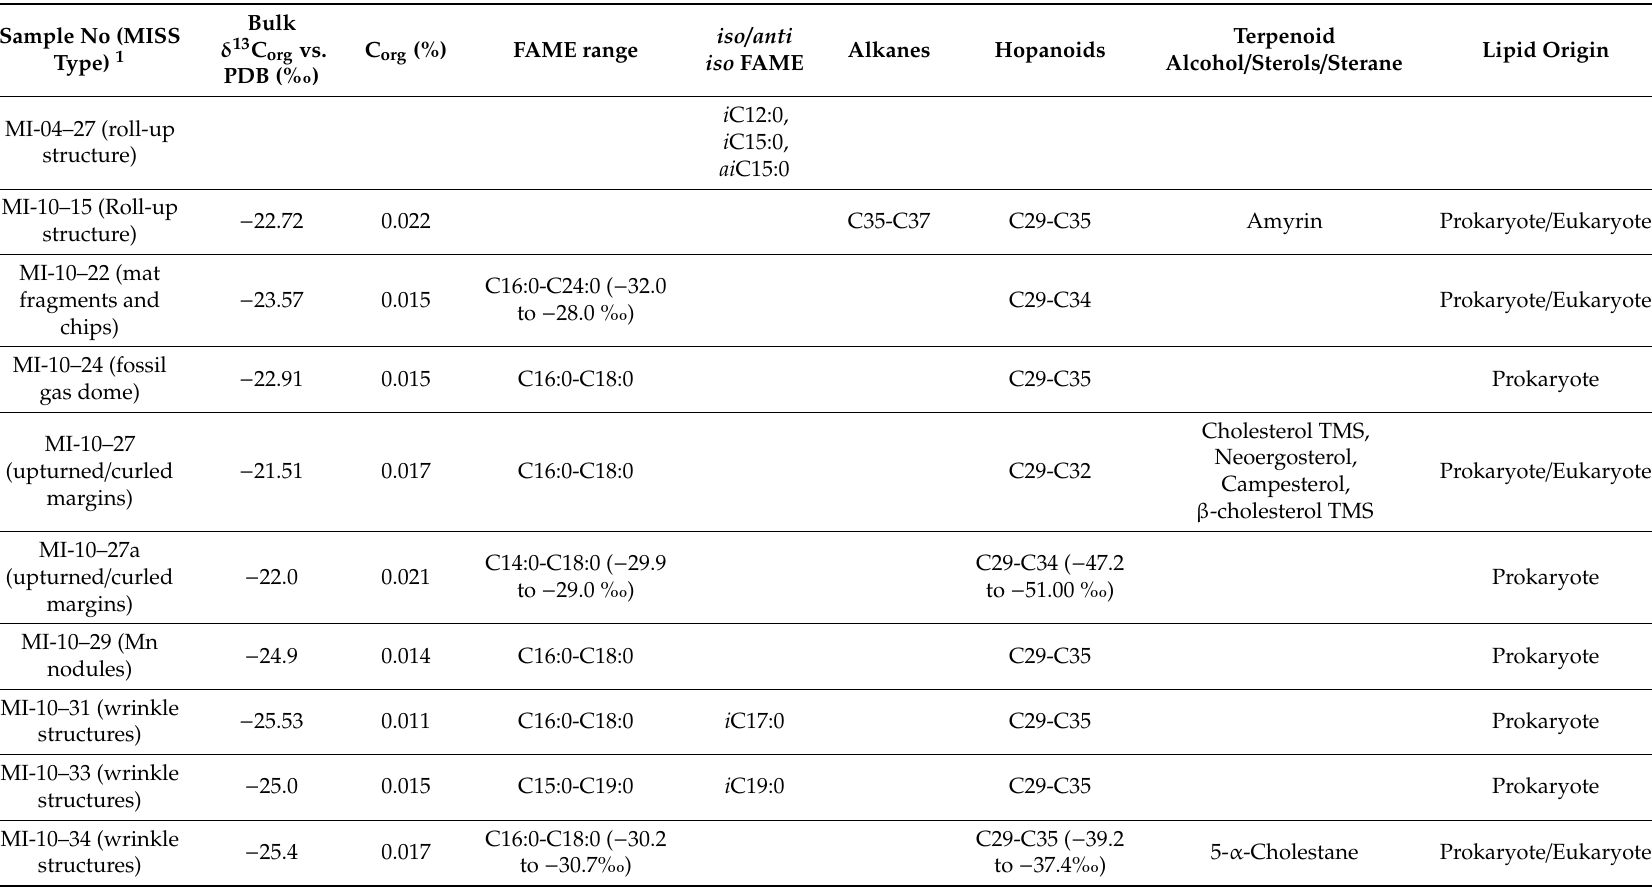
Table 2. Summary of bulk δ 13 C org (% (cid:24) ), C org (%) and lipid biomarker analysis. Lipid specific δ 13 C org (% (cid:24) ) values are shown in